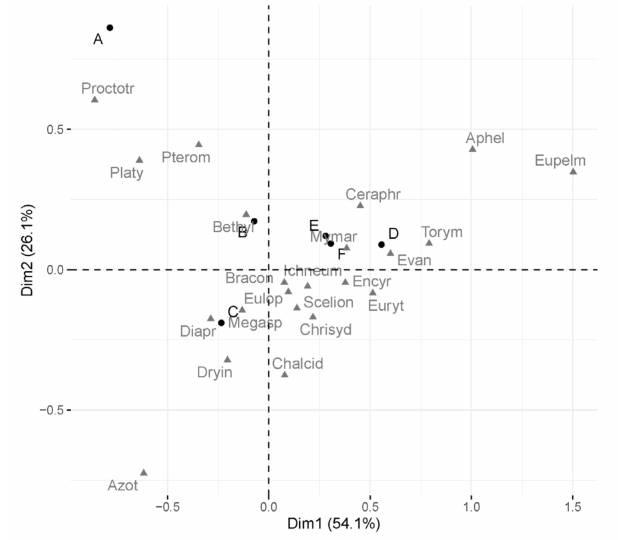
Figure 2. Correspondence analysis of 2018 field data showing the association of hymenopteran parasitoid families to each sampled olive orchard (i.e., A − F, with increasing pest density from A to F). The first dimension of CA explains 54.1% of the total variance, while dimension 2 explains 26.1%: Platy, Platygastridae; Pterom, Pteromalidae; Encyr, Encyrtidae; Eulop, Eulophidae; Euryt, Eurytomidae; Eupelm, Eupelmidae; Aphel, Aphelinidae; Azot, Azotidae; Torym, Torymidae; Mymar, Mymaridae; Chalcid, Chalcididae; Ichneum, Ichneumonidae; Bracon, Braconidae; Proctotr, Proctotrupidae; Diapr, Diapriidae; Ceraphr, Ceraphronidae; Megasp, Megaspilidae; Bethyl, Bethylidae; Scelion, Scelionidae; Dryin, Dryinidae; Chrisyd, Chrisydidae; Evan,